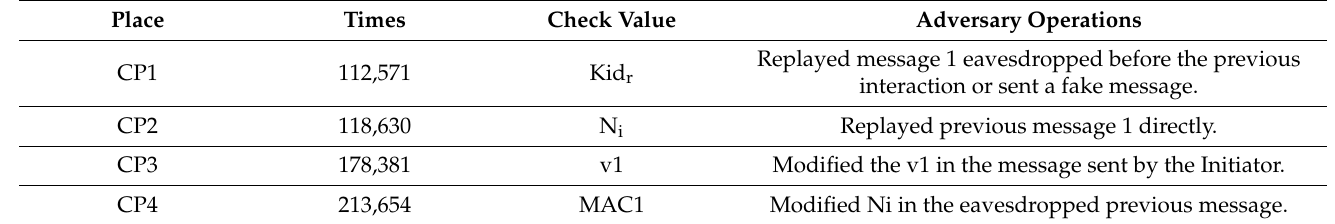
Figure 18. The simulation results in observation places. Table 5. Interpretation of simulation results at